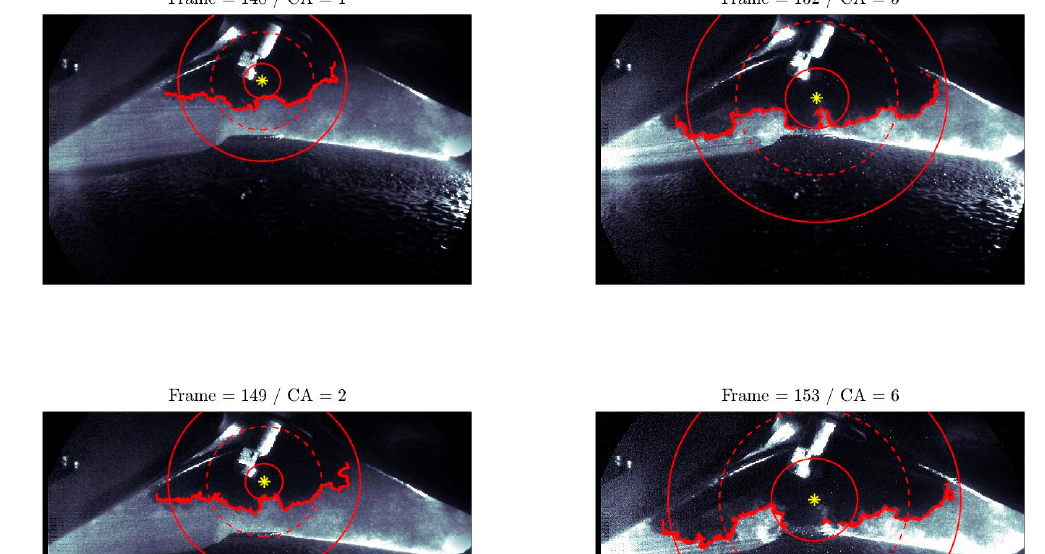
Figure 15. Cycle 60. Background corrected images of turbulent flame from − 7 CAD to TDC firing. Superimposed geometric properties: flame edges, flame center, min, max, and average radii. Engine operation: 1000 RPM, wide open throttle.